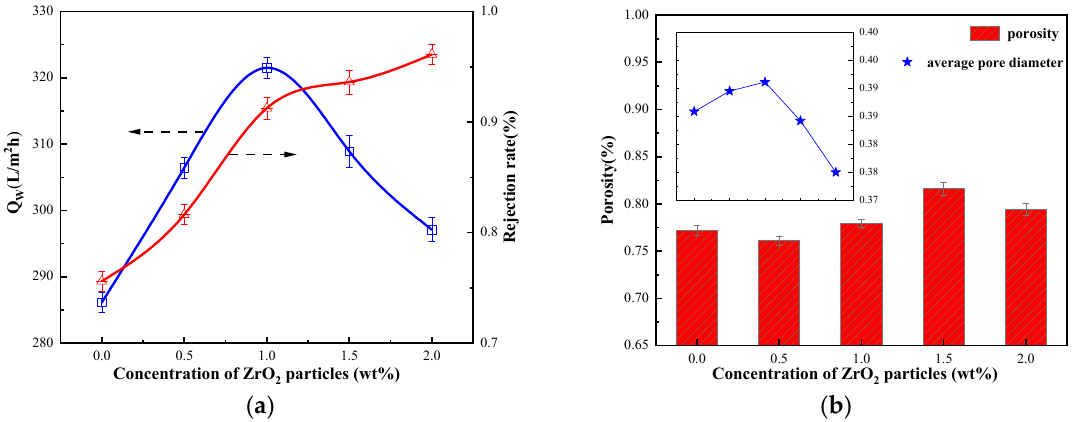
Figure 3. ( a ) Filtration performance of cellulose membrane with nanoparticles; ( b ) Porosity of cellulose membranes with nanoparticles.